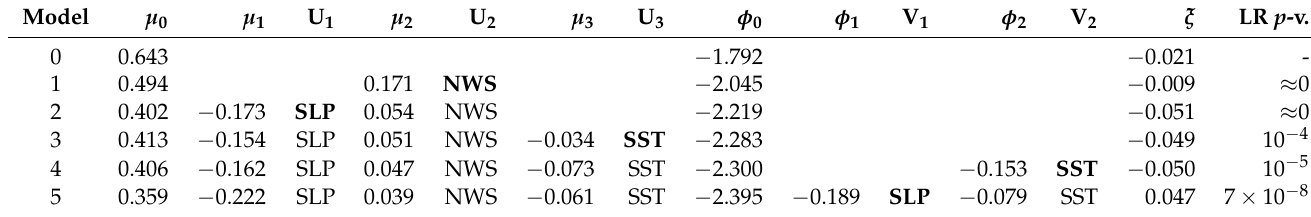
Table 1. Hyperparameter estimates and corresponding covariates for the best model at each step of the mixed selection for the S nonstationary NHPP model when the scale parameter is kept constant. The rightmost column gives the p -value of the likelihood ratio test with the preceding model. The covariate added at each step is indicated in bold 1 . These results correspond to the parametric regressions of Equations (2) to (4). Information criteria are not reported in this table because in this case of nested models, using them would be equivalent to having likelihood ratio tests with different α